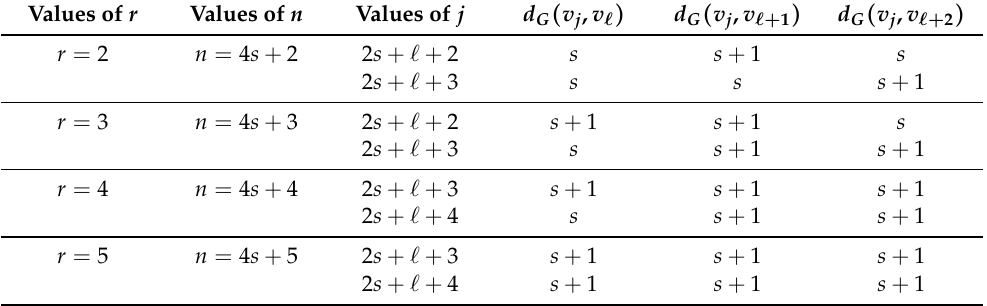
(cid:8) (cid:4) r (cid:5) + (cid:4) r (cid:5) + (cid:9) Table 3. The distances of v (cid:96) , v (cid:96) + 1 , and v (cid:96) + 2 from v j , where j ∈ 2 s + (cid:96) + 1,2 s + (cid:96) + 2 . 2 2 Values of r Values of n Values of j d G ( v j , v (cid:96) ) d G ( v j , v (cid:96) + 1 ) d G ( v j , v (cid:96) + 2 ) r = 2 n = 4 s + 2 2 s + (cid:96) + 2 s s + 1 s 2 s + (cid:96) + 3 s s s + 1 r = 3 n = 4 s + 3 2 s + (cid:96) + 2 s + 1 s + 1 s 2 s + (cid:96) + 3 s s + 1 s + 1 r = 4 n = 4 s + 4 2 s + (cid:96) + 3 s + 1 s + 1 s + 1 2 s + (cid:96) + 4 s s + 1 s + 1 s + 1 2 s + (cid:96) + 4 s + 1 s + 1 s +